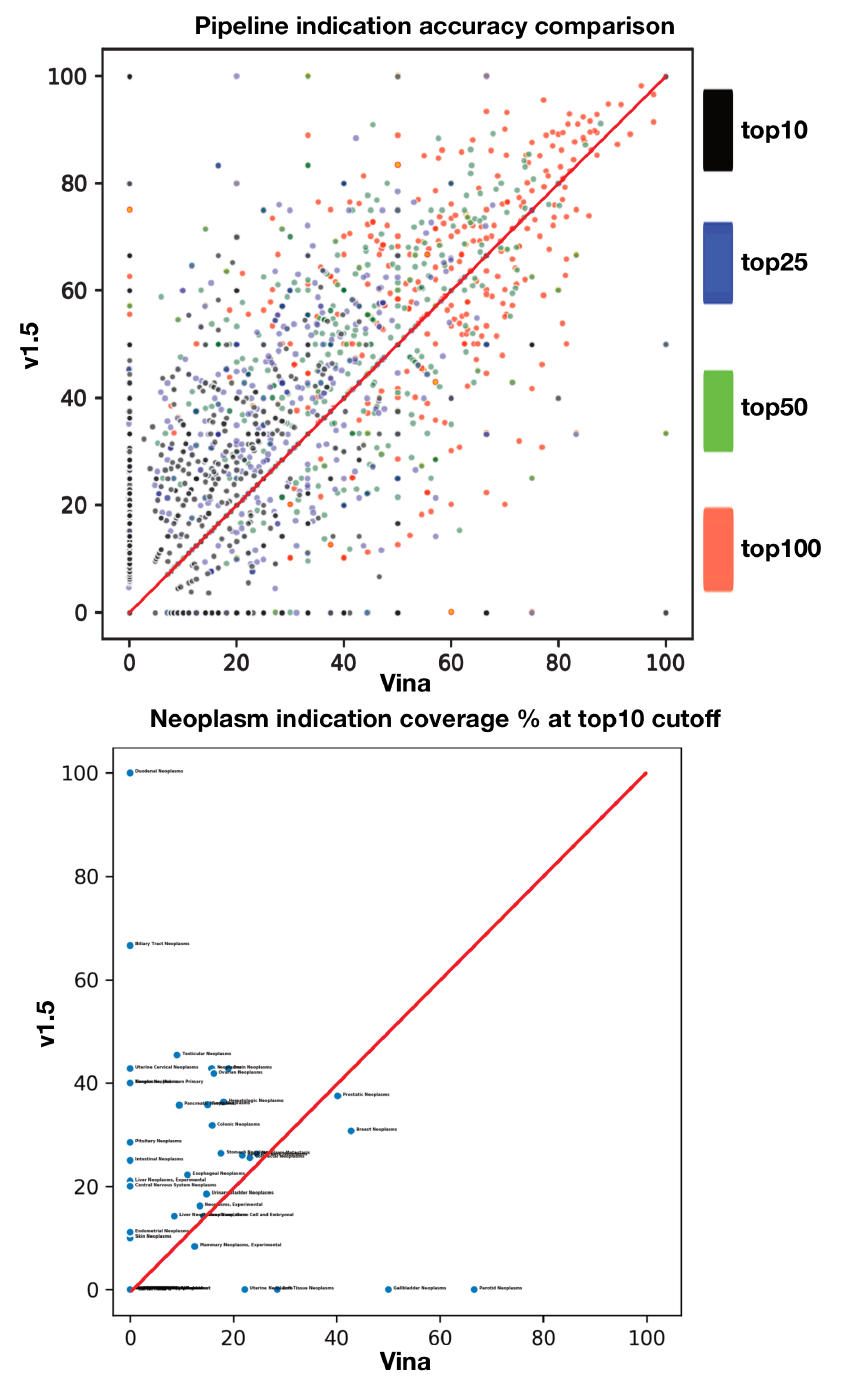
Figure 6. Comparison of the indication accuracies at various cutoffs and for a defined indication class for two CANDO platform pipelines. The top panel denotes a symmetrical accuracy chart. Each axis measures the indication accuracy for each pipeline, and indications are plotted according to their corresponding accuracies (different cutoffs are distributed in alternate colors). Points that land on the 45 degree red line are indications where the pipelines reached consensus; points that fall closer to a particular axis achieved a relatively higher score with the corresponding pipeline. The bottom panel isolates indications for the defined class “neoplasm” comprising 39 indications with the corresponding string. The asymmetrical distribution of the accuracy plot suggests pipeline accuracy differentiation, i.e., different pipelines have differing performance strengths and weaknesses, on a per-indication and indication class